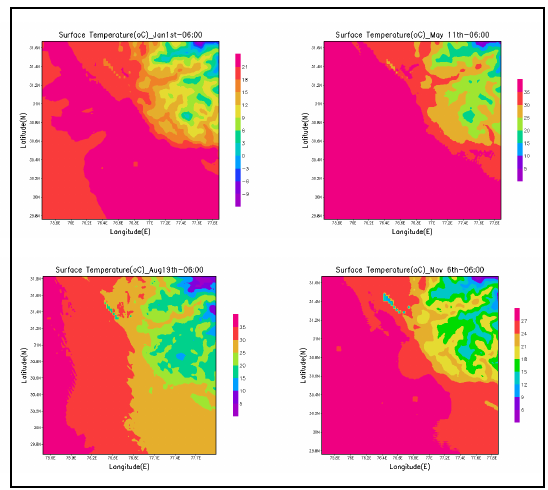
Figure 3. Spatial distribution of Temperature over d02 on different 1st 11th seasons Jan 11:30 IST, May 11:30 IST, Aug th th 19 11:30 IST and Nov 6 11:30 IST with BEP+BEM Urban